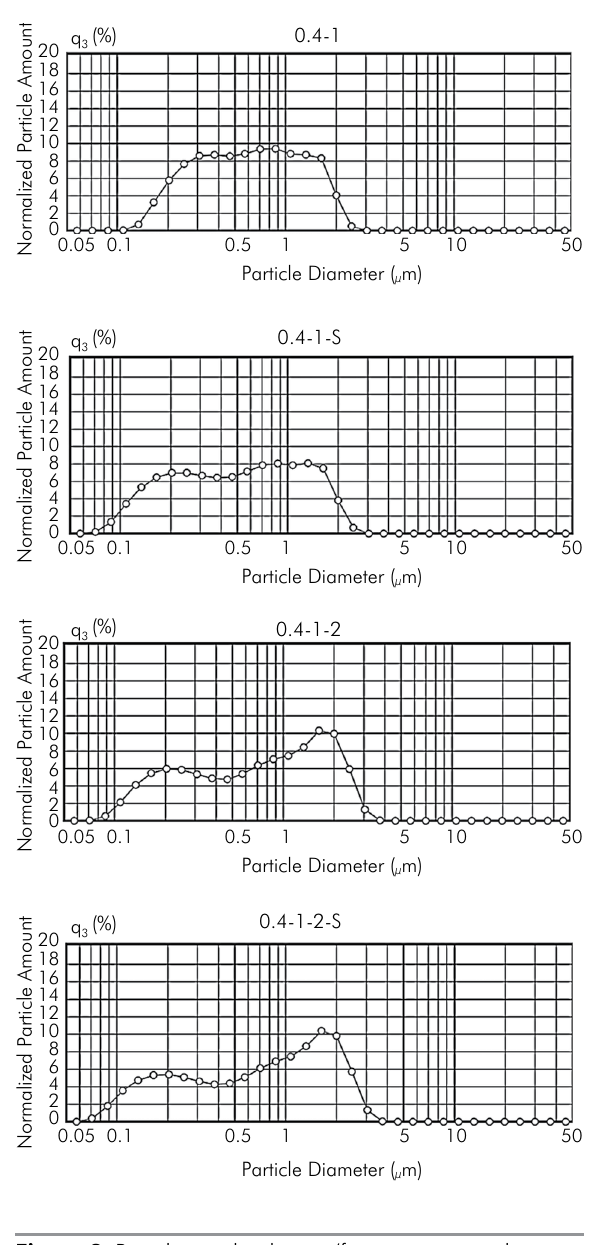
Figure 2. Particle size distribution (frequency versus diameter, in μm) of the filler